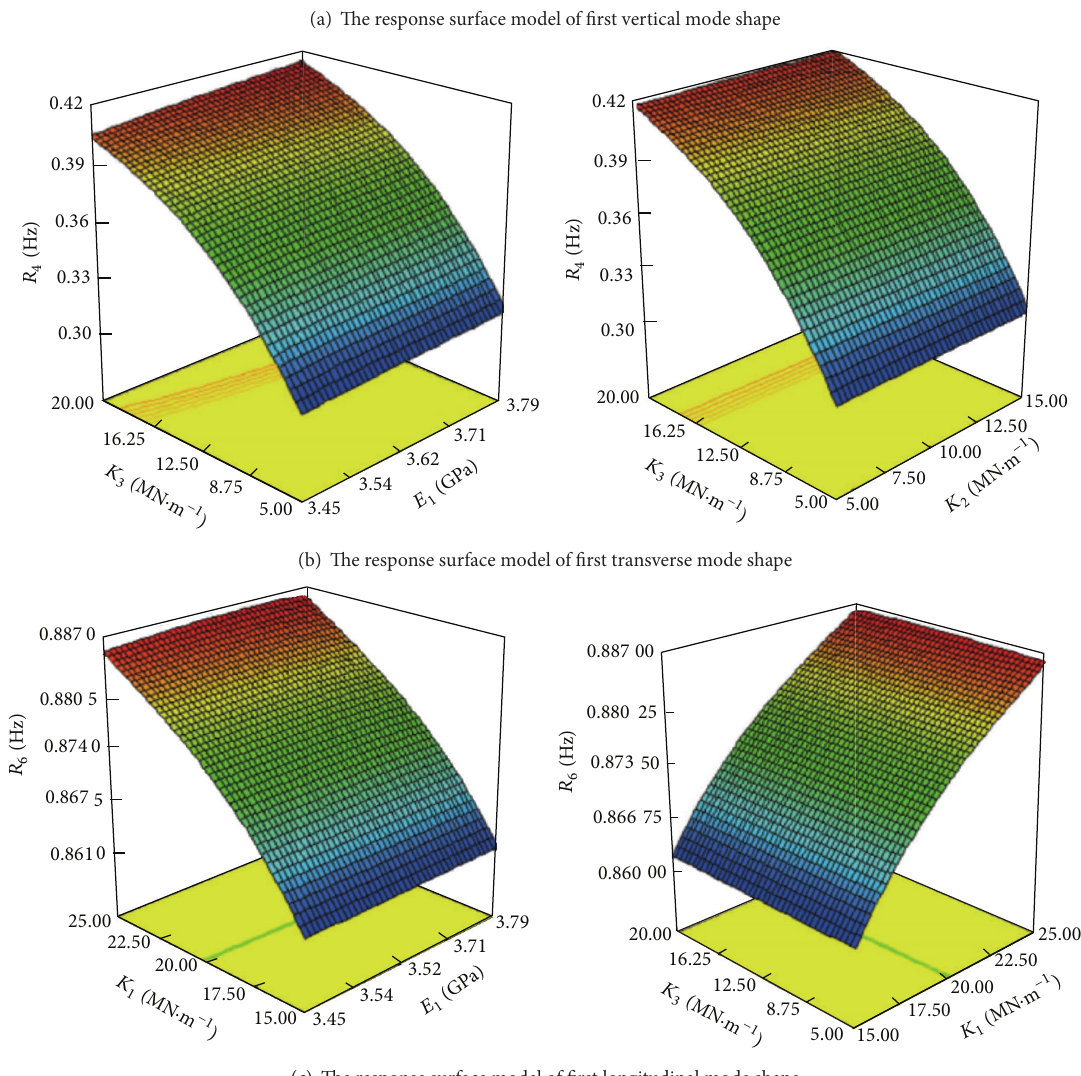
(c) The response surface model of first longitudinal mode shape Figure 9: The response surface model of mode